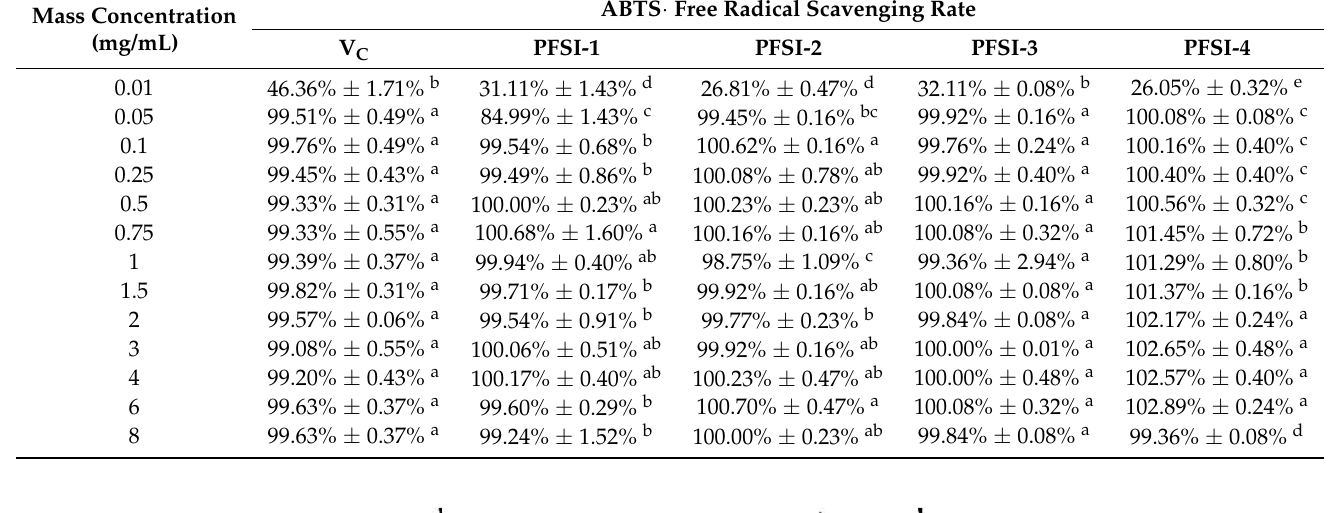
Table 6. ABTS· free radical scavenging by PFSI-1, PFSI-2, PFSI-3, and PFSI-4. (Note: same lowercase letters indicate no significant difference between groups, different lowercase letters indicate a sig- nificant difference between groups, p < 0.05).